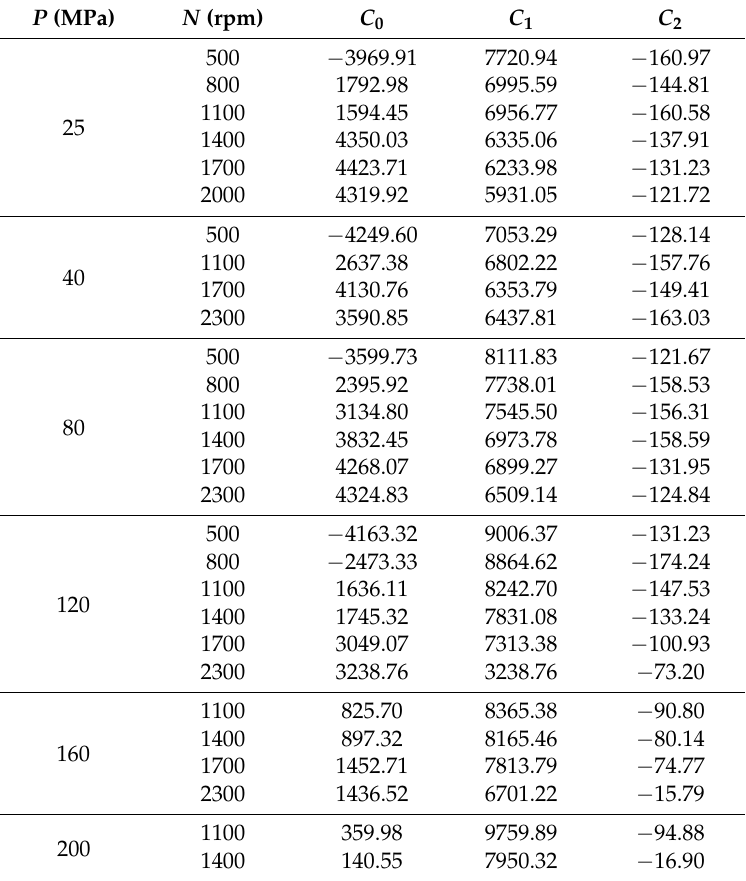
Table 2. The coefficient of different welding